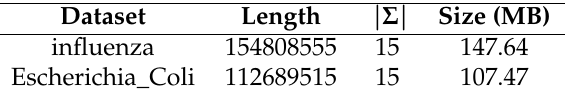
Table 4. Summary of additional datasets.